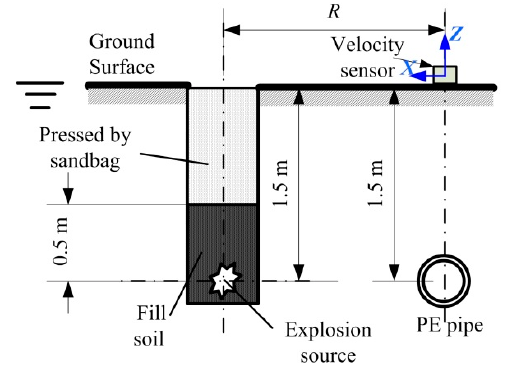
Figure 3. The location of the PE pipe and explosion source.